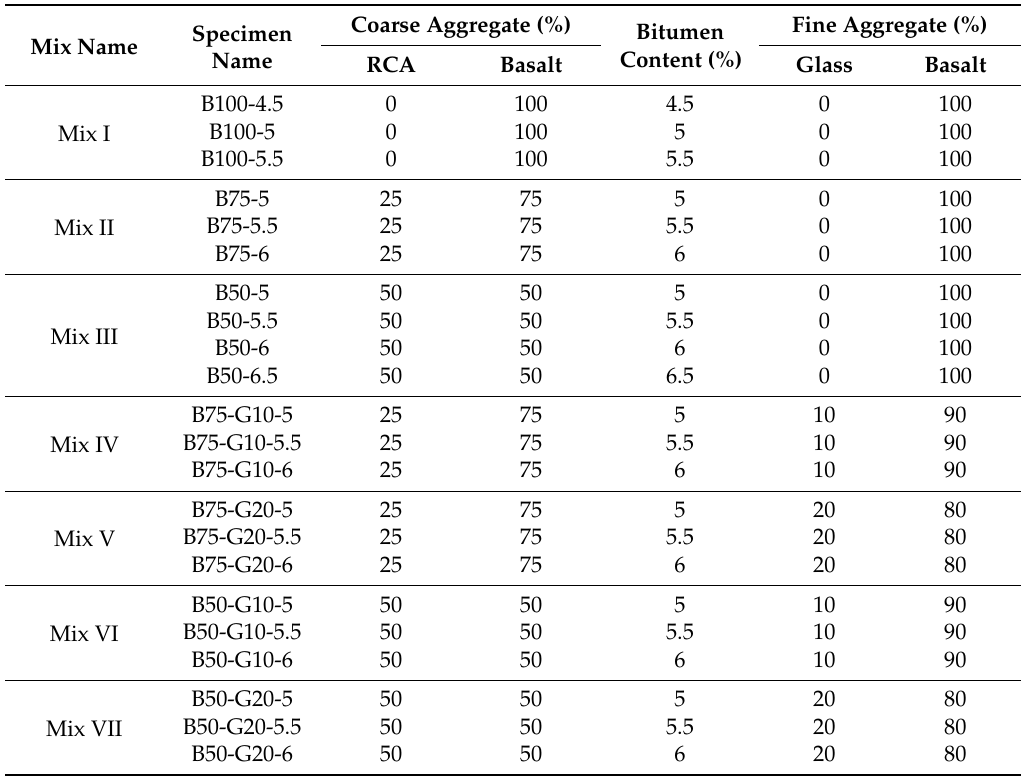
Table 3. Bitumen and aggregate mix combination